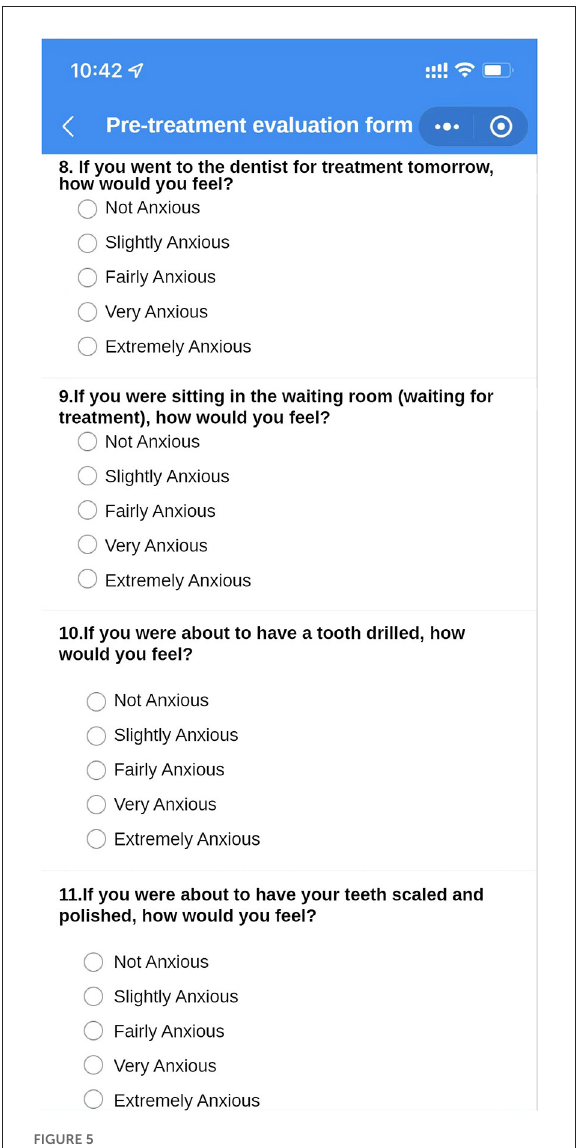
FIGURE5 Pre-treatment assessment interface. Part of the Modified Dental Anxiety Scale (MDAS). After filling in the questions, the intelligent assessment system will send the assessment results and risk prediction to the doctor’s